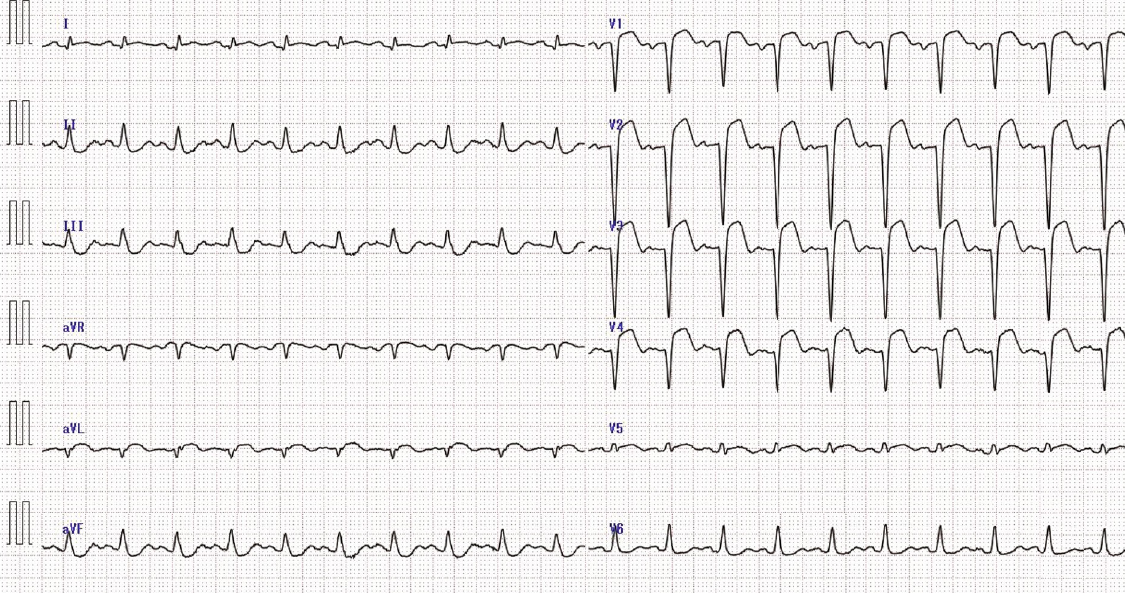
Figure 1: Electrocardiogram showing ST-segment elevation in V1-4.